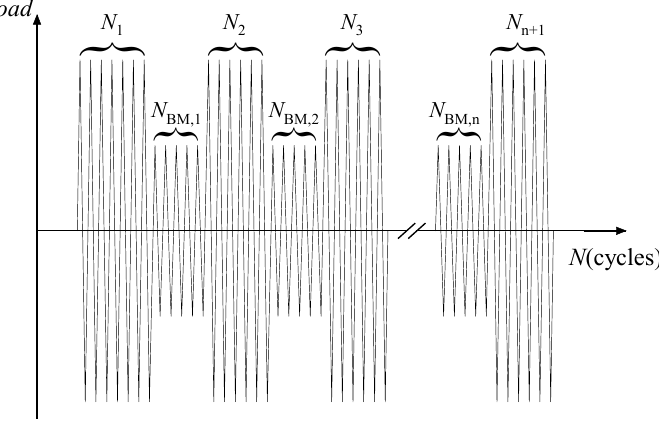
Figure 6. Schematic load sequence.